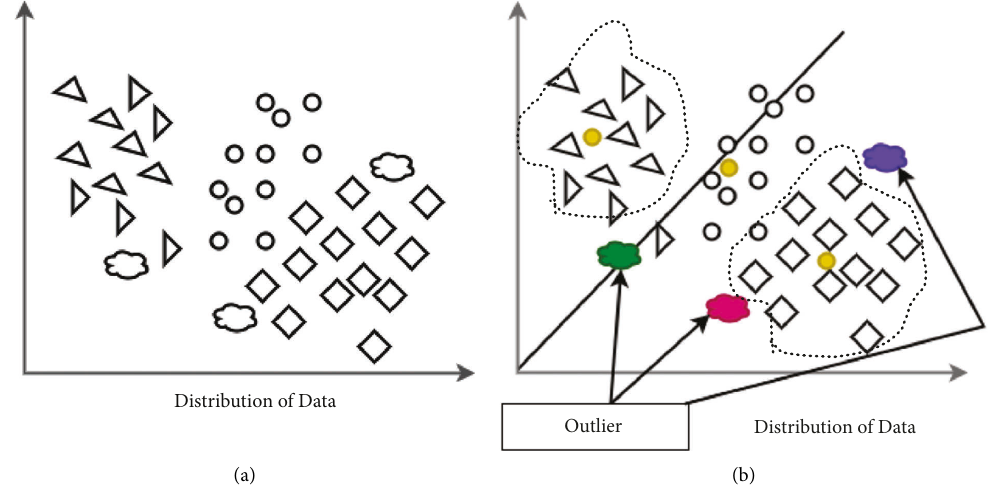
Figure 2: Centroid clustering-based outlier elimination (a) Before Clustering, (b) After